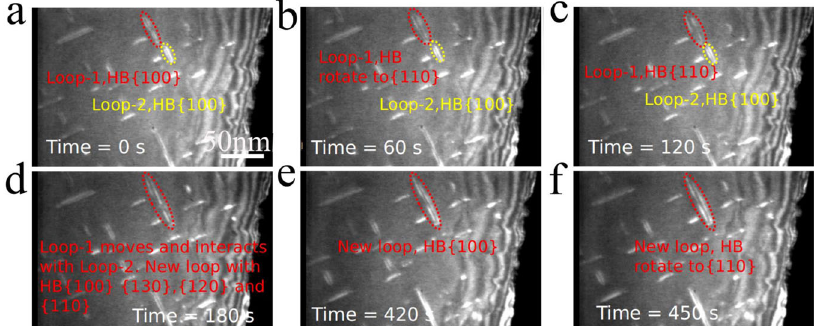
Fig. 5 Direct in situ TEM observations of a <100> loop diffusion through habit plane rotation. The rotation of a loop (loop-I) is shown in a – c , and two loops are shown by small red and yellow dot ellipses, respectively. The rotation of the large loop after interaction is shown in d – f . Total time of in situ observation is up to 450